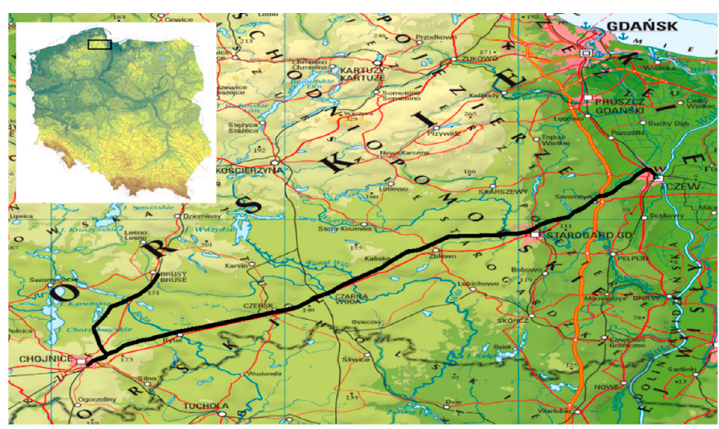
Figure 8. The route of railway surveys with aligned 2D coordinates.